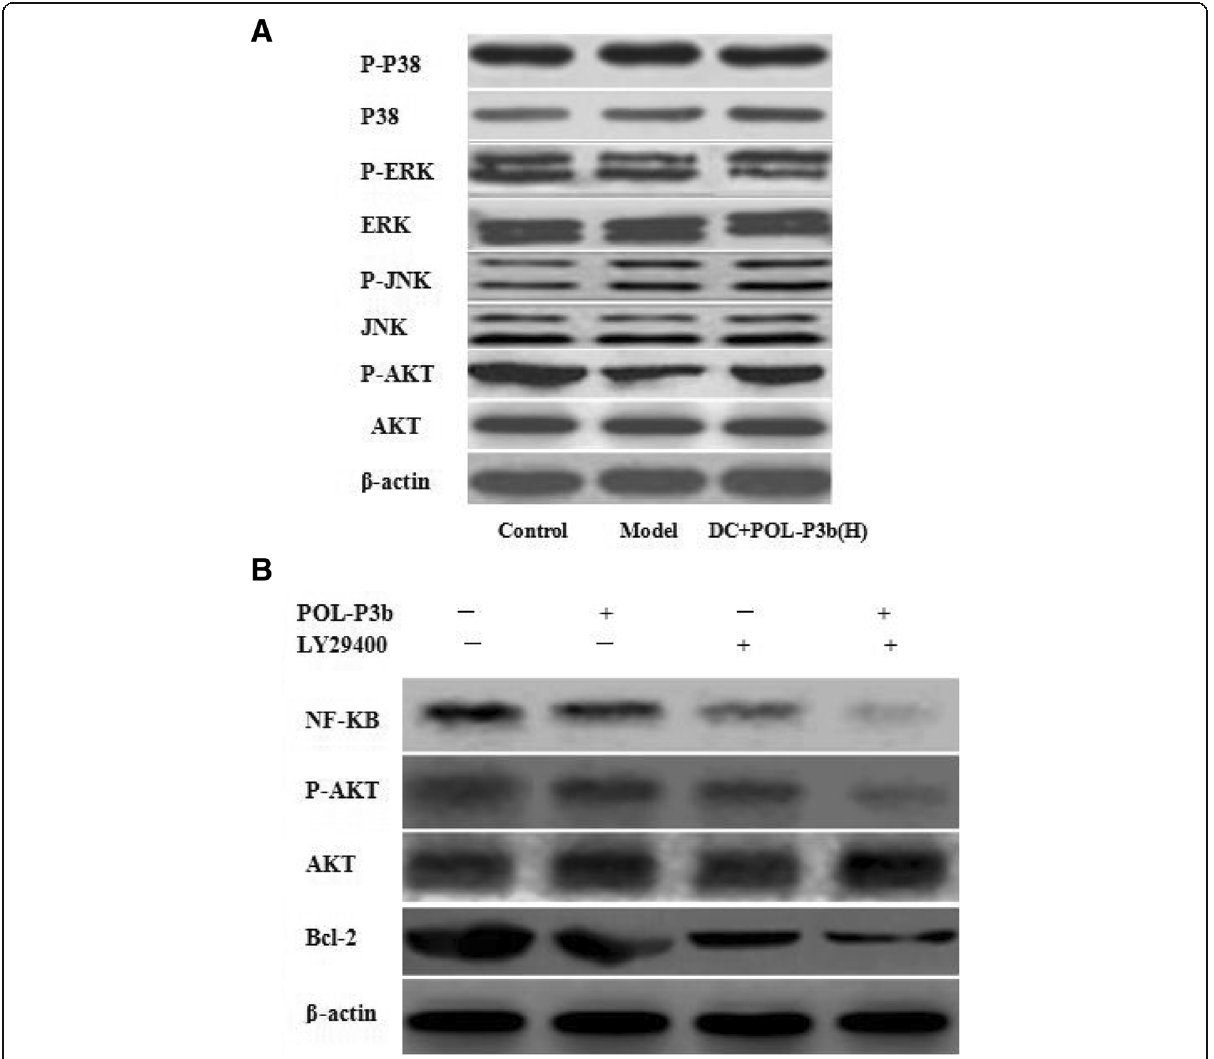
Fig. 5 Activity of POL-P3b-induced protection of intestinal DC from cervical cancer-induced apoptosis involved in PI3K/AKT and NF- κ B signaling pathway a Western blot analysis showing the levels of phosphorylated p38, ERK, JNK and AKT in intestinal DC. b The PI3K downstream target was analyzied. Intestinal DC isolated from mice treated with or without POL-P3b were pretreated by LY294002 (60 μ mol/L) for 1.5 h. The Akt activity, the NF- κ B activation and the expression of Bcl-2 in intestinal DC was suppressed by the pretreatment of